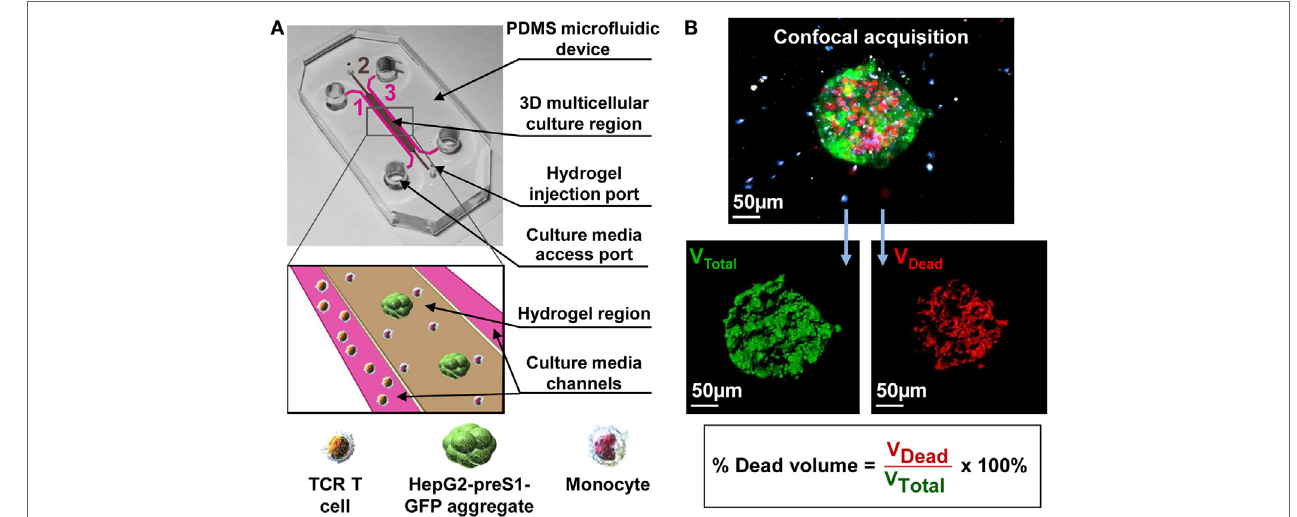
FigUre 1 | (a) A 3D multicellular tumor microenvironment microfluidic model consisting of a middle hydrogel channel (2) flanked by two media channels (1, 3) for the mechanistic study of the effect of monocytes on T cell receptor-redirected T cell (TCR T cell) killing of tumor cell aggregates. Human monocytes were inserted together with target HepG2-preS1-GFP cell aggregates in collagen gel in the central hydrogel region (2), while hepatitis B virus (HBV)-specific TCR T cells were added into one fluidic channel (1) to mimic the intrahepatic carcinoma environment. (B) Representative confocal image of a target cell aggregate (in green) surrounded by monocytes (in blue) and HBV-specific TCR T cells (in white), in which the presence of dead target cells is DRAQ7 + (in red). Target cell death is quantified as shown based on the DRAQ7 + volumetric portion in the total volume of each GFP-labeled